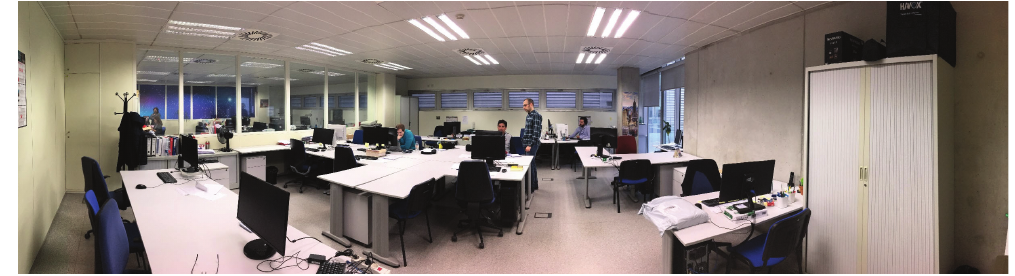
Figure 1. Panoramic view of the propagation